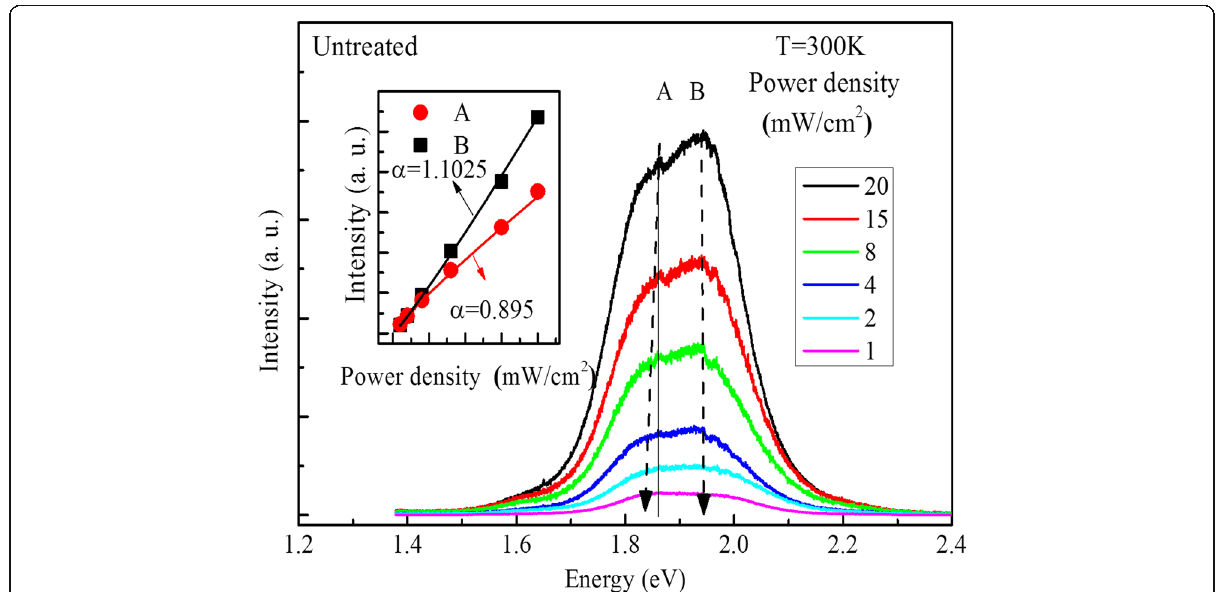
Fig. 2 The excitation power-dependent PL spectra of the untreated sample. The insert picture is the integrate intensity of peaks with the change of excitation power; the solid lines are theoretical fitting